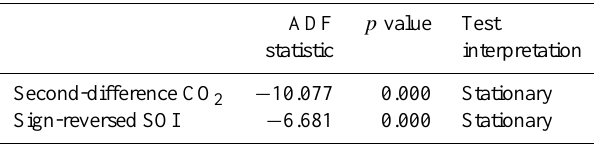
Table 9. Augmented Dickey–Fuller (ADF) test for stationarity for monthly data 1959–2012 for second-difference CO 2 and sign- reversed